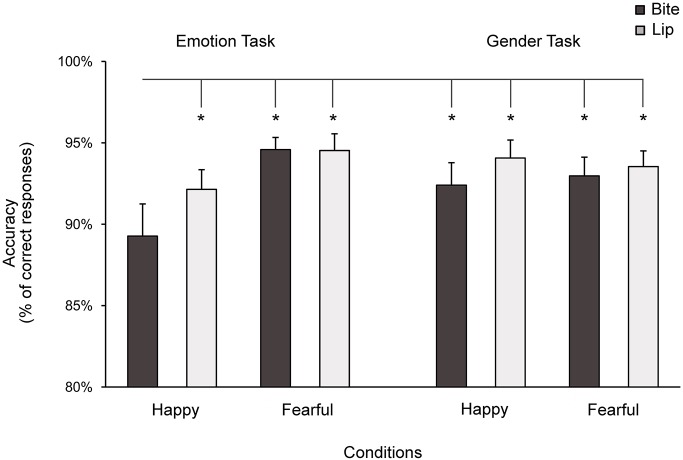
Mean accuracy in Experiment 2.When biting a pen, participants’ ability to accurately identify happy expressions was decreased relative to all the other conditions. Asterisks indicate significant comparisons. Error bars indicate s.e.m.